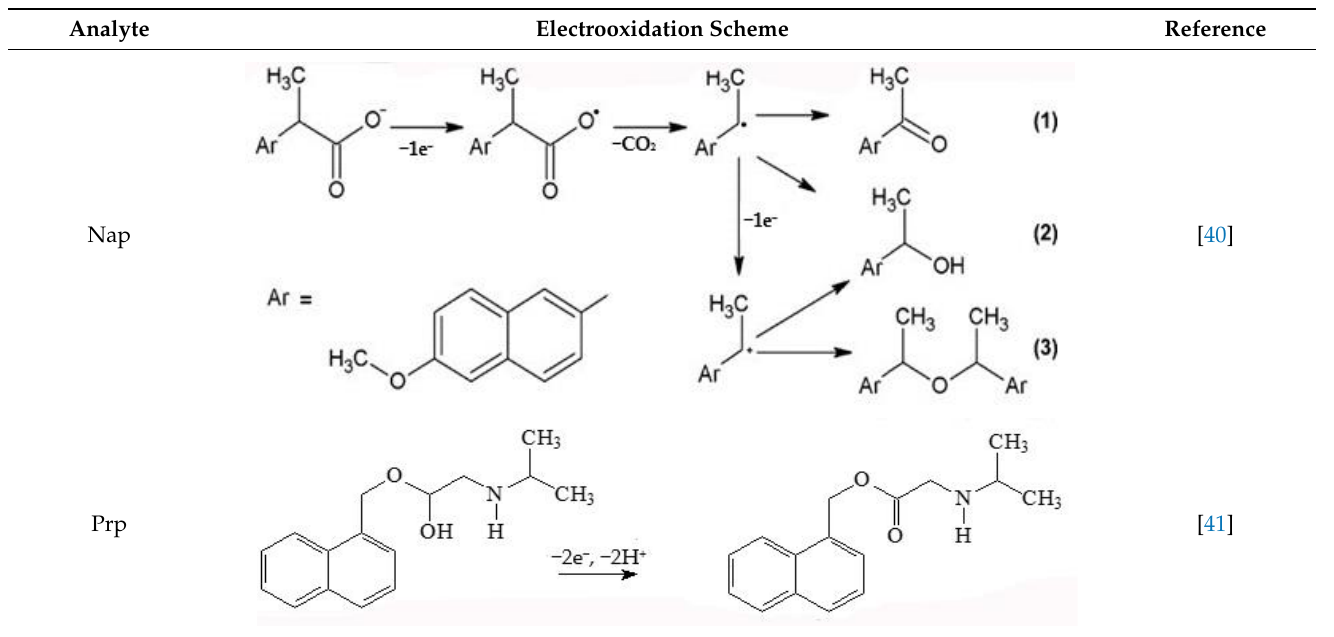
Table 2. Comparison of the enantioselectivity of unmodified and modified sensors based on a GCE.